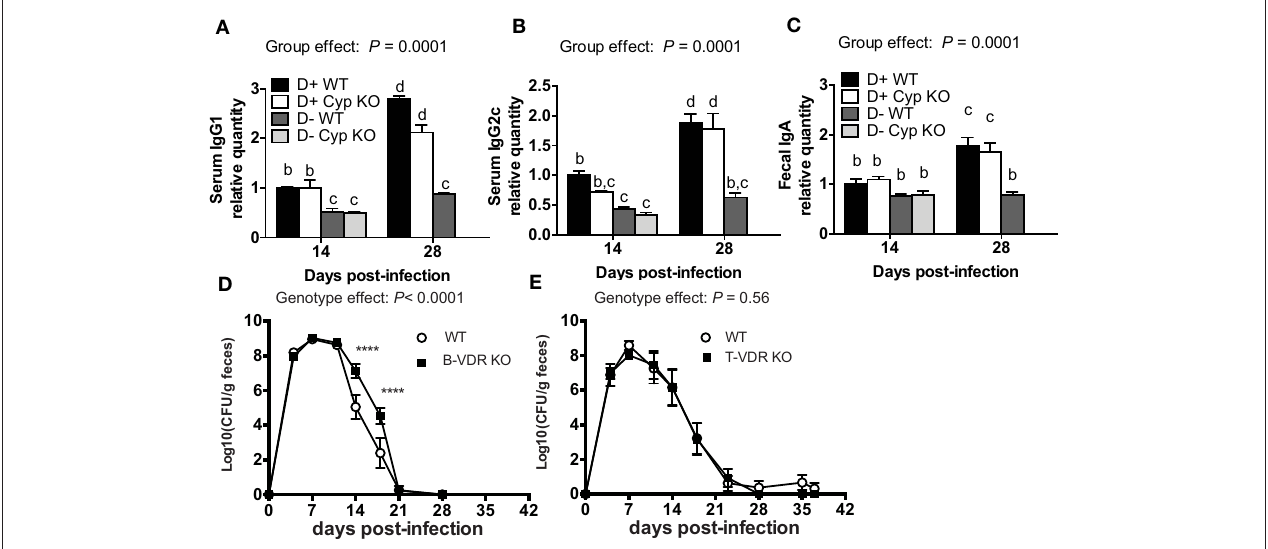
FIGURE 2 | Indirect roles of vitamin D in B cells and T cells for clearance of C. rodentium . The amount of C. rodentium -specific (A) IgG1 and (B) IgG2c in the serum. Fecal (C) C. rodentium specific IgA. D + WT values at d14 were set at 1 and other values are relative to the D + WT value. Values are from two independent experiments and the mean ± SEM of n = 6–8 mice per group. Two-way ANOVA with Bonferroni post-hoc tests (A–C) . Groups without a common letter differ at the indicated time point, P < 0.05. Fecal shedding of C. rodentium in (D) WT and B-VDR KO or (E) WT and T-VDR KO littermates following C. rodentium infection. Values are the mean ± SEM of two combined experiments and n = 9–13 mice per group. Significance was determined using two-way ANOVA with Bonferroni post-hoc tests. **** P < 0.0001.